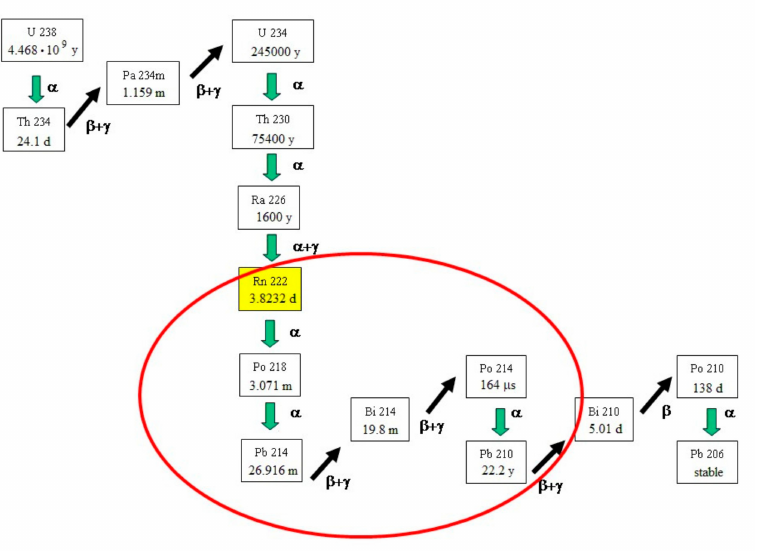
Figure 1. The lower part of the uranium series in atmosphere: the six radionuclides considered in this work are circled in